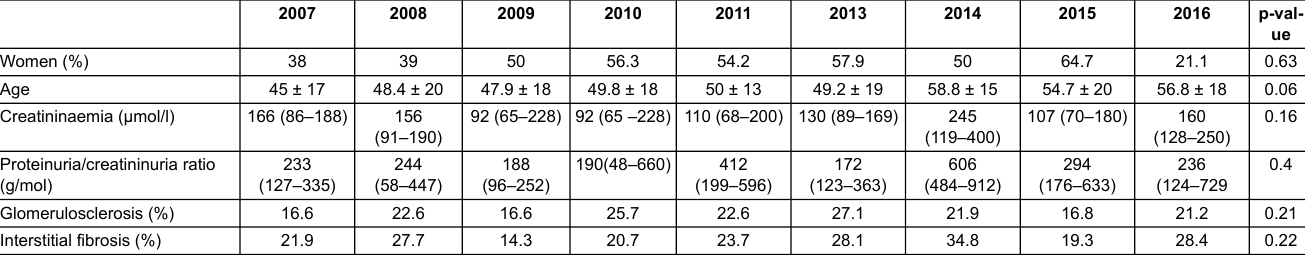
Table 3: Comparison of baseline characteristics of patients with firstly diagnosed primary glomerulonephritis between 2007 and